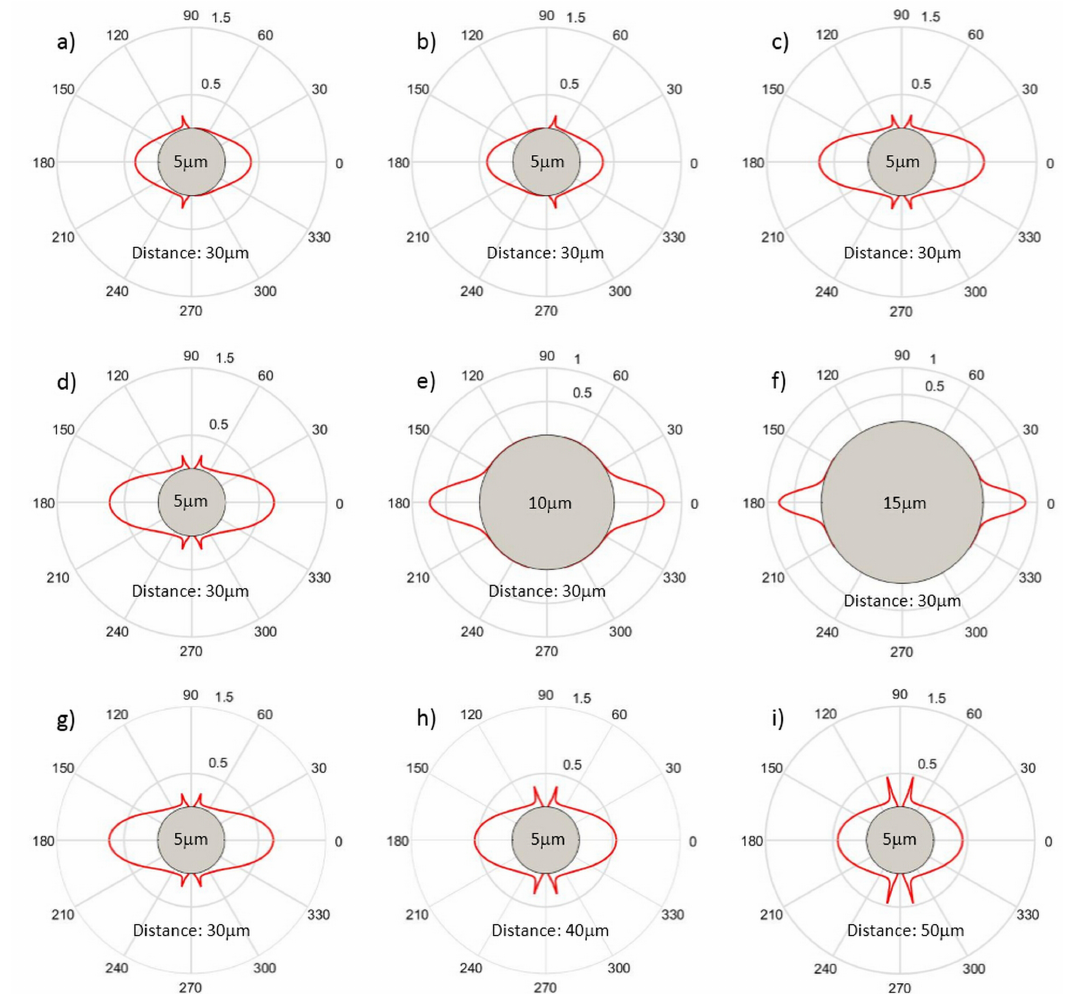
Figure 8. Polar plots of the calculated optical stress distribution on the surface of the particle. The Gaussian laser beam has beam waist of 3.1 µm and wavelength of 1.07 µm and carries optical power of 10 mW. The refractive index of the particle is 1.37 and medium 1.33. The distance between the particle center and the beam waist (either one laser or two lasers) is indicated in each panel together with the diameter of the particle. ( a – c ) show the optical stress from left side laser radiation, right side laser radiation and both side laser radiation respectively; From ( d ) to ( i ), the two-side laser irradiation is considered; ( d – f ) show the optical stress distribution change with particle size increase; ( g – i ) show the optical stress distribution change with distance